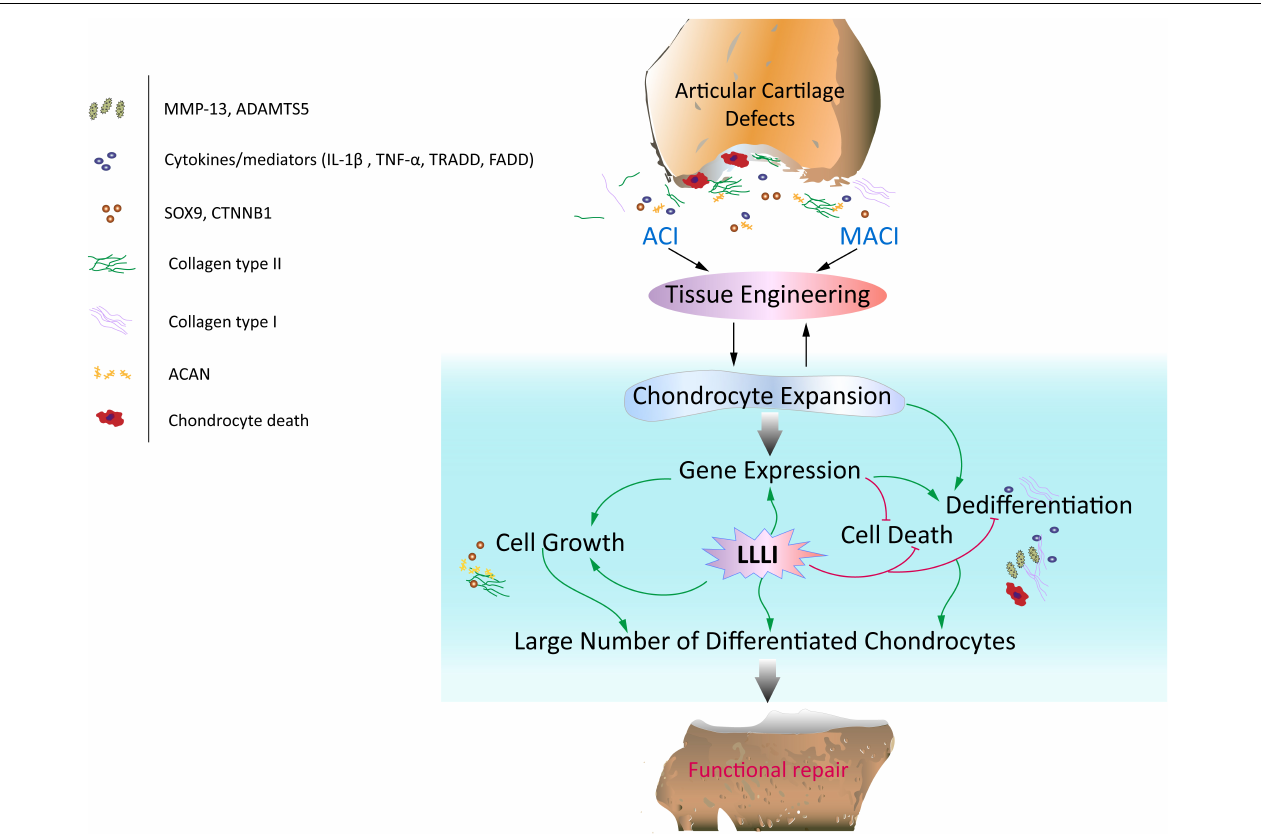
FIGURE 8 | Schematic illustration of the potential of LLLI to synergize with currently effective clinical cell-based therapies for articular cartilage defects. Autologous chondrocyte implantation (ACI) and matrix-induced autologous chondrocyte implantation (MACI) procedures rely on generation of a large number of chondrocytes expanded ex vivo , which secrete matrix component proteins in a homeostatic manner for regeneration of hyaline cartilage essential for restoration of functional joints. In vitro expansion of chondrocytes by conventional cultivation usually results in dedifferentiation to fibroblastic chondrocytes less capable of regenerating functional cartilage. Laser irradiation biostimulation was assessed for its capacity to generate large numbers of chondrocytes in culture potentially useful in functional repair of defected cartilage. The doses of low level laser irradiation (LLLI) applied in this study stimulated the expression of chondrogenic genes such as Sox9 , CTNNB1 , Acan and Col2 α 1 , and inhibited “destructive” factors/mediators including the cytokines IL-1 β and TNF- α , members of the death cascade, matrix degrading enzymes and the fibroblastic Cal1 α 1 leading to increased proliferation and reduced cell death and the generation of large numbers of cultured chondrocytes with high viability and a differentiated phenotype suitable for therapeutic applications in tissue